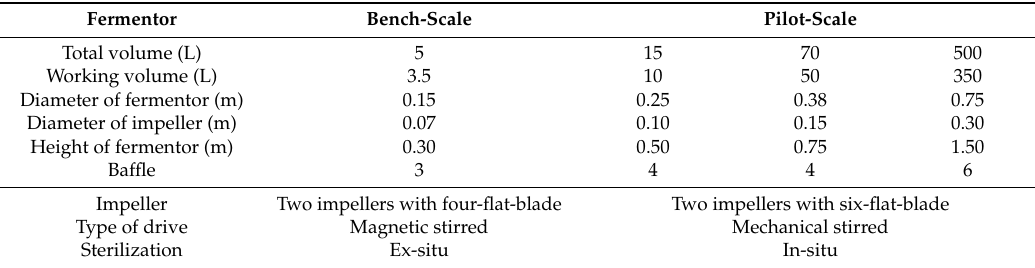
Table 5. The specifications of